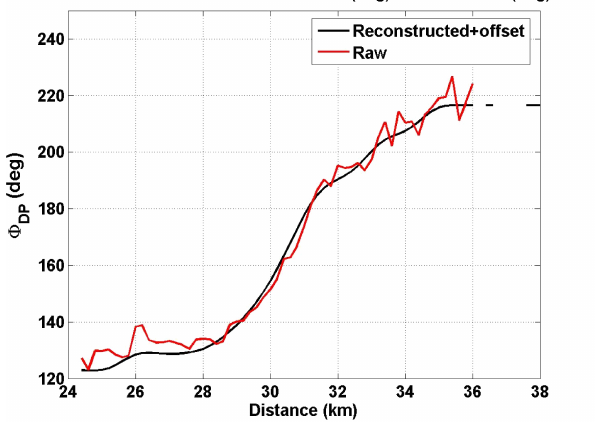
Figure 2. Examples of observed and filtered (cid:56) DP range profiles observed on 21 August 2013 at 04:50UTC. The estimated offset has been added to the filtered (cid:56) DP to simply the